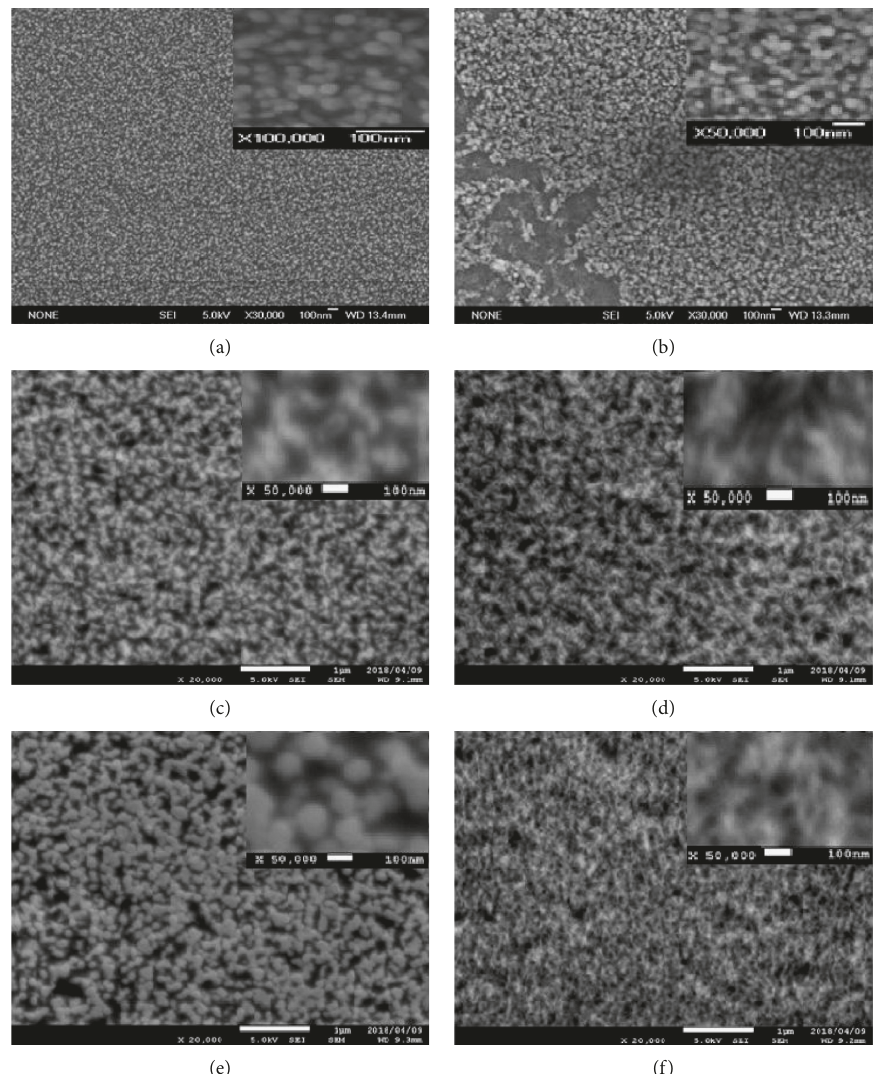
Figure 2: SEM images (top view) of ZnO NRs from both ZA (left column) and ZN (right column) sources processed with the waterbath method for growth time t � 0, 90, and 120 minutes. (a) t � 0 minutes, ZA. (b) t � 0 minutes, ZN. (c) t � 90 minutes, ZA (d) t � 90 minutes, ZN. (e) t � 120 minutes, ZA (f) t � 120 minutes,